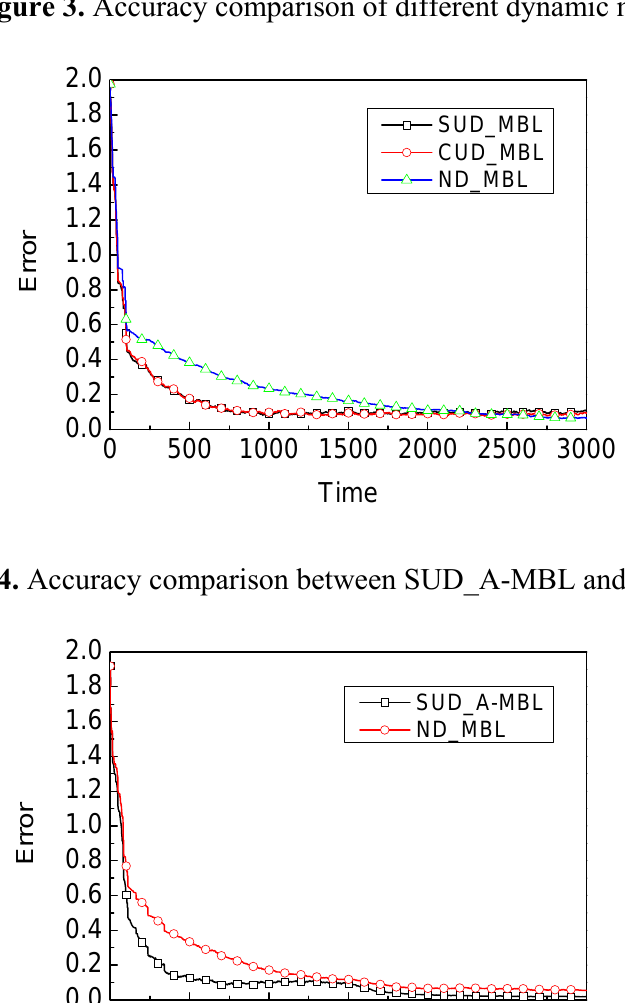
Figure 3. Accuracy comparison of different dynamic model.